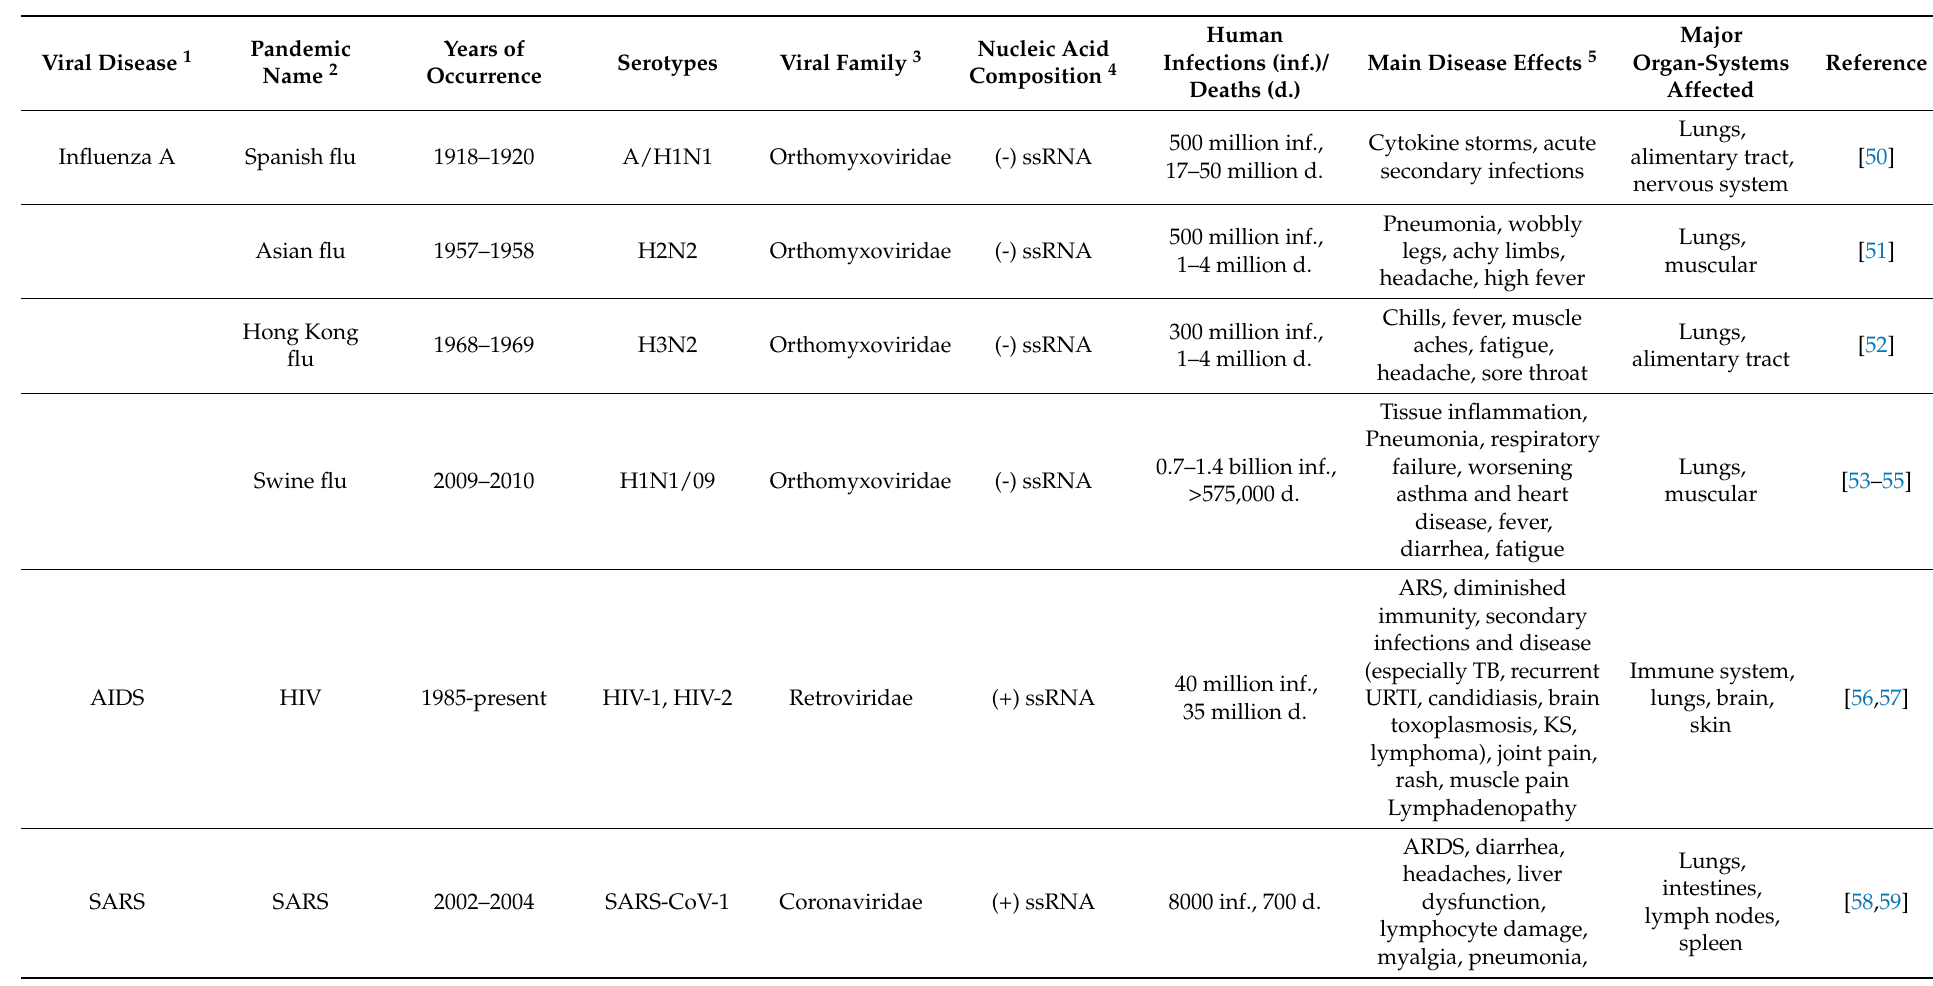
Table 1. Molecular characteristics, classifications, and physiological impacts to human organs and organ systems caused by major viral diseases responsible for global